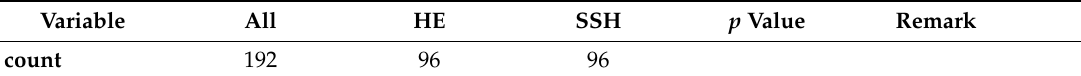
Table 3 . Postoperative complications and issues .